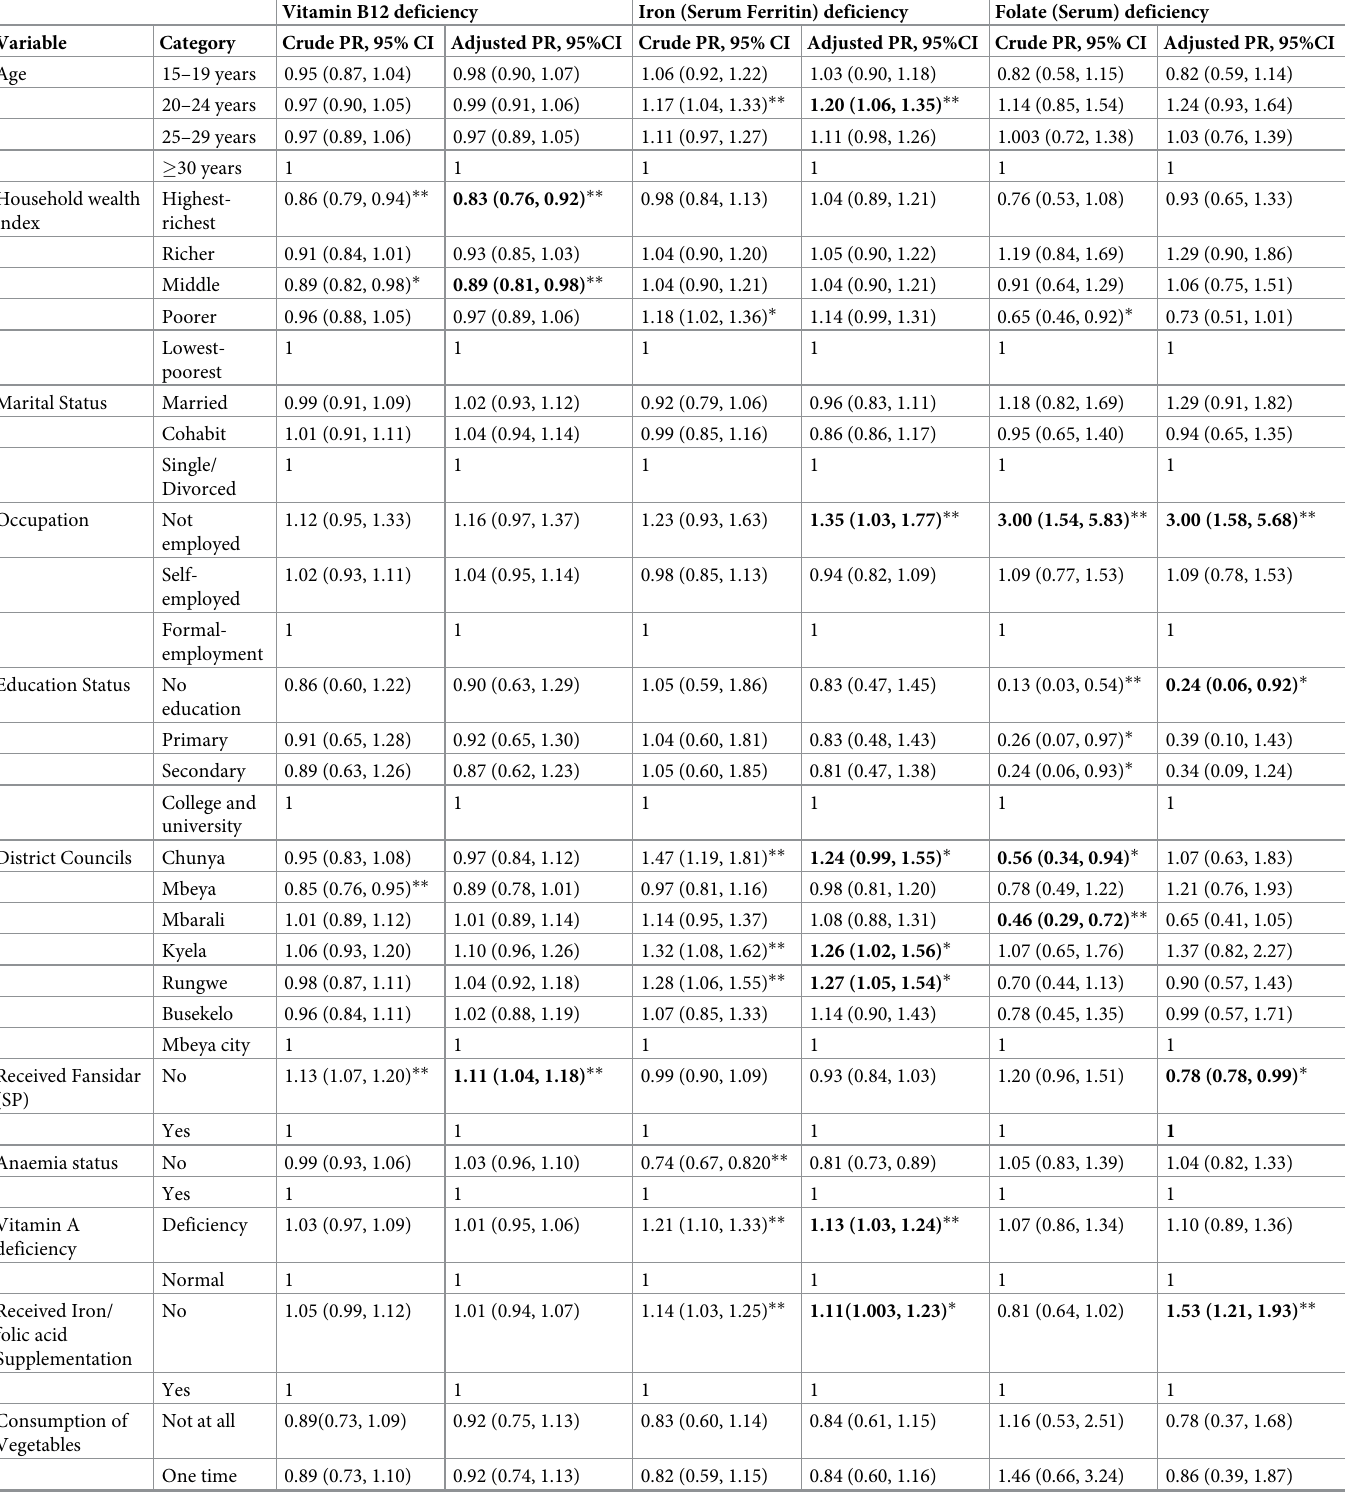
Table 3. Socio-demographic, economic, and dietary factors associated with vitamin B12, Iron (serum ferritin), and folate (serum) deficiencies among pregnant women in Mbeya Tanzania (n = 420). Vitamin B12 deficiency Iron (Serum Ferritin) deficiency Folate (Serum) deficiency